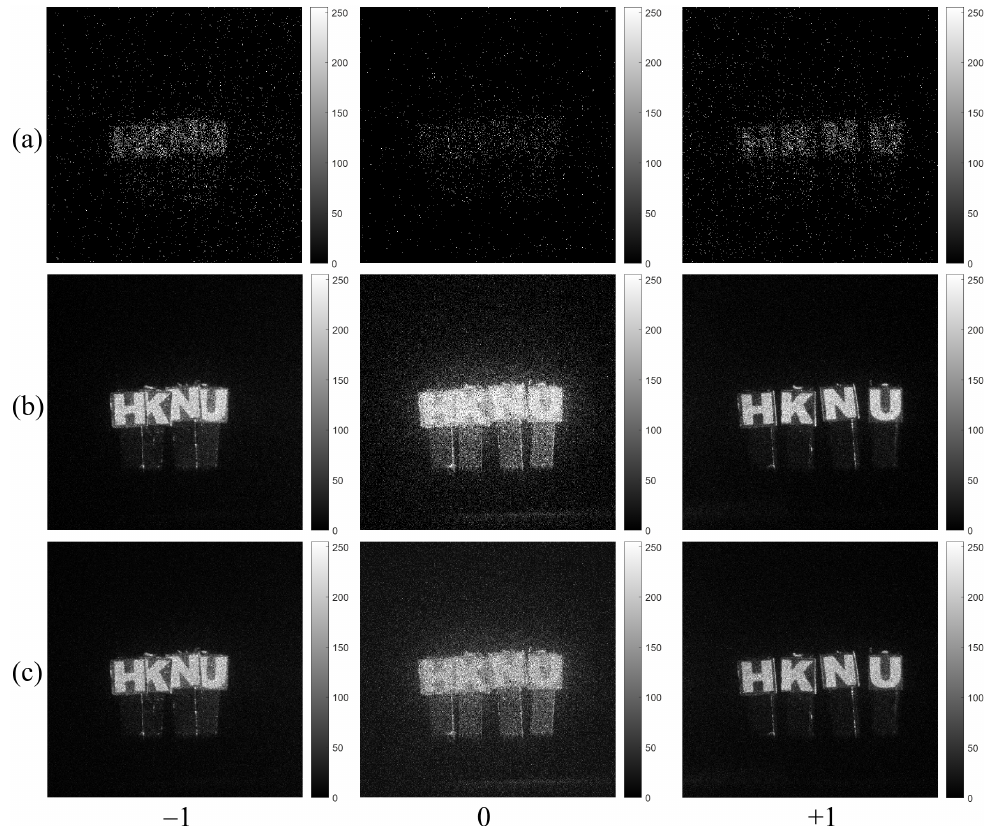
Figure 9. Diffraction images of HKNU objects by photon counting imaging with 1% photon ratio by ( a ) Single observation, ( b ) N = 100 observations of MLE, and ( c ) N = 100 observations of MAP,